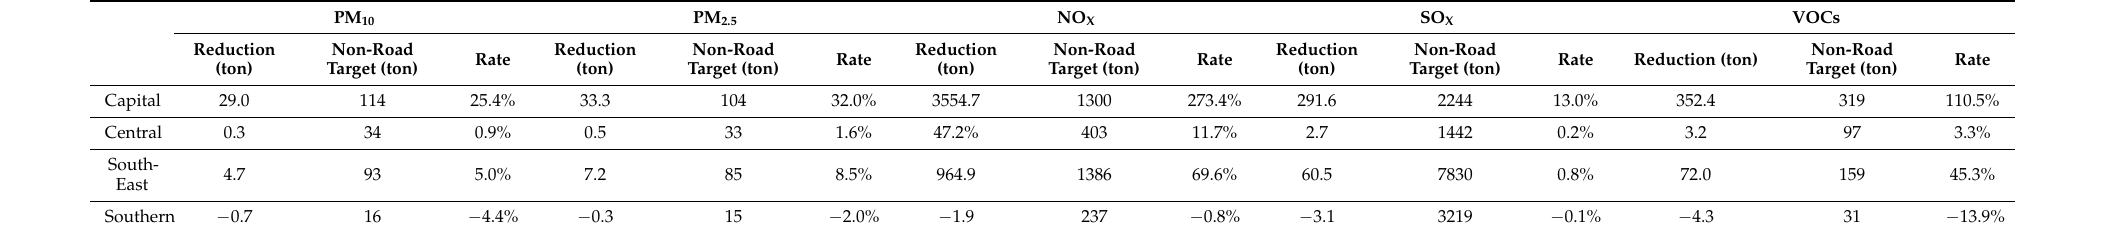
Table 7. Emission Reduction due to COVID-19 and Non-road Emission Reduction Target in Air Control